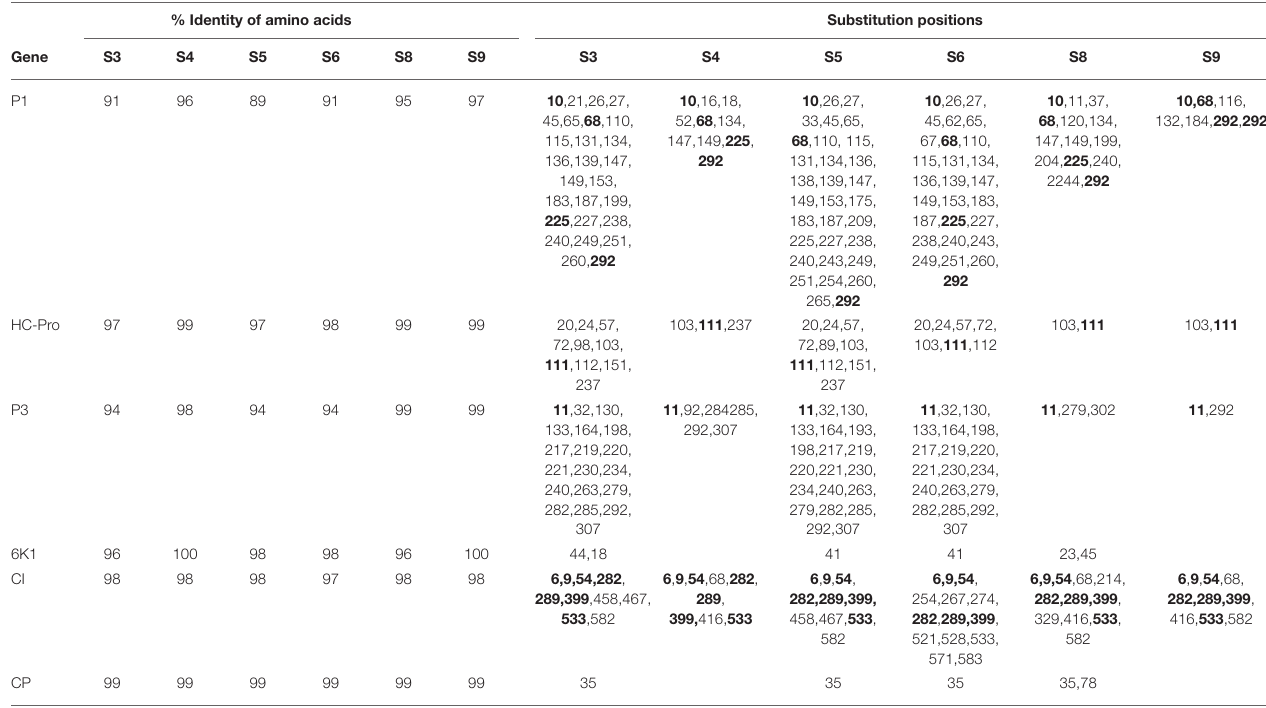
TABLE 5 | Summary of amino acid sequence comparisons between BCMNV strain TM-70 and S3, S4, S5, S6, S8, S9. % Identity of amino acids Substitution